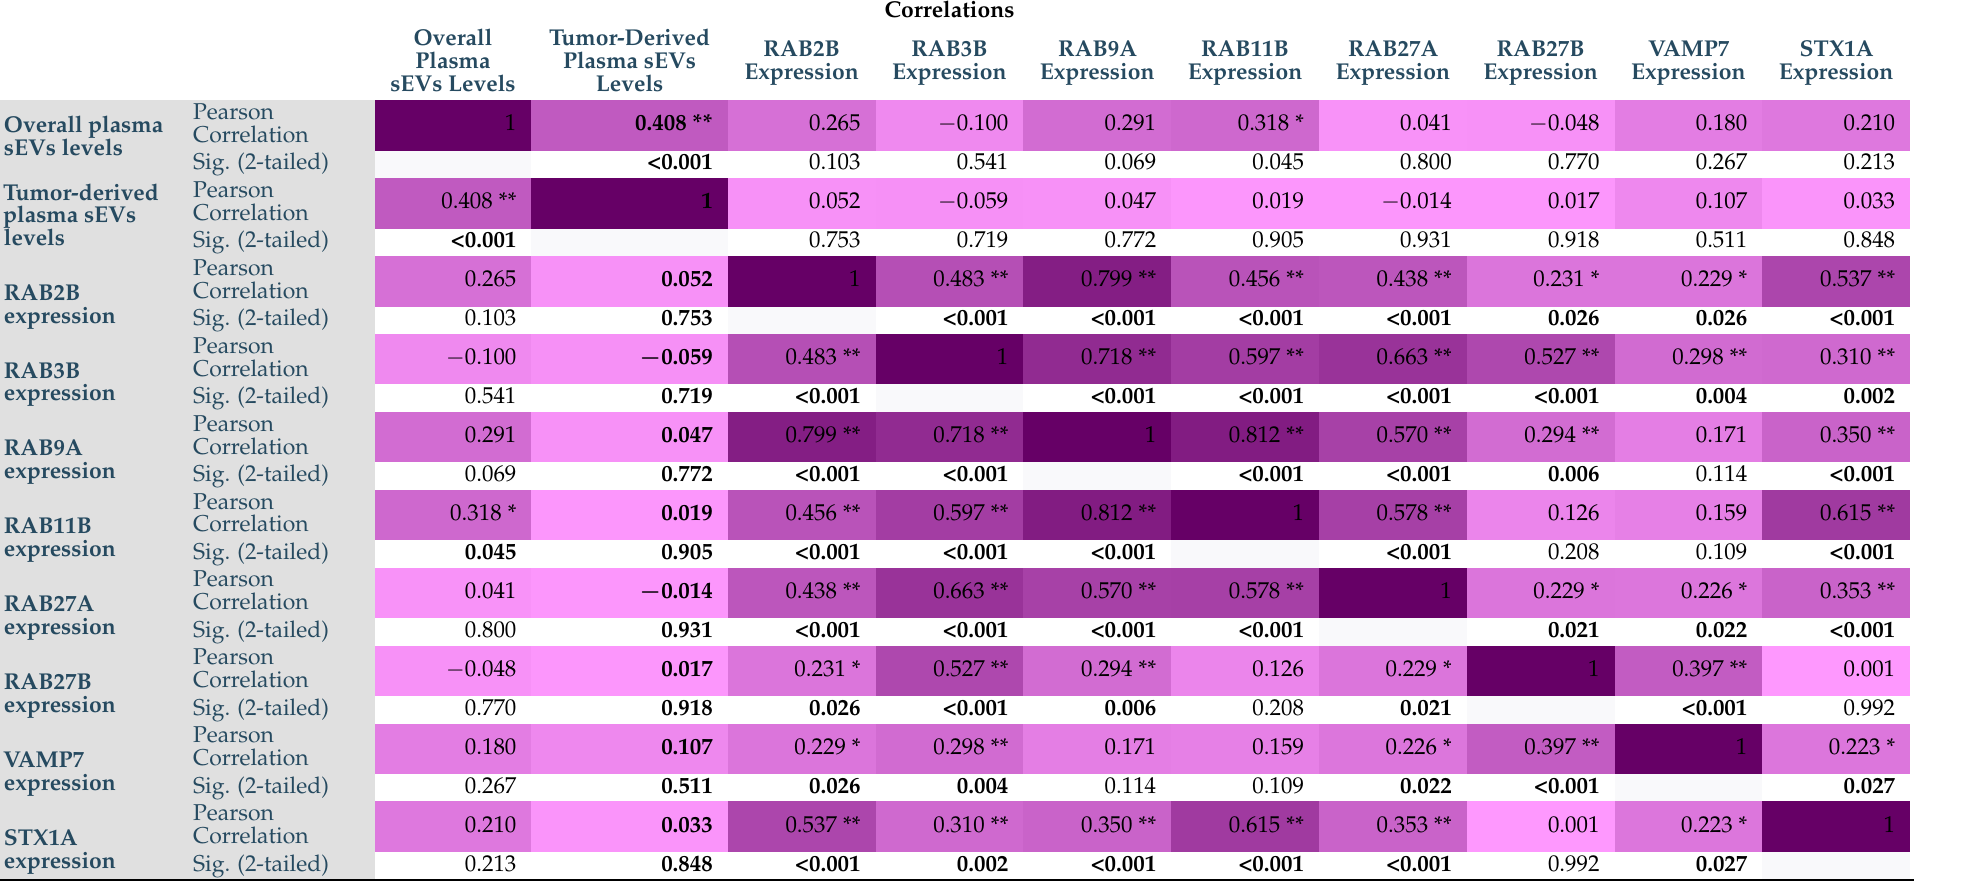
Table 3. Correlation coefficients and p values among sEVs concentrations and genes expression